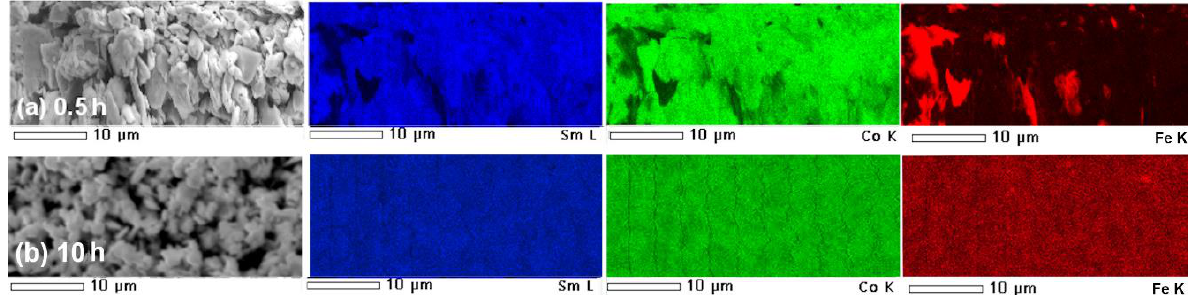
Figure 4. SEM energy-dispersive X-ray spectroscopy (EDS) elemental distribution maps measured for SmCo 5 /α-Fe (5%wt. of α-Fe) composites milled for ( a ) 0.5 and ( b ) 10 h.